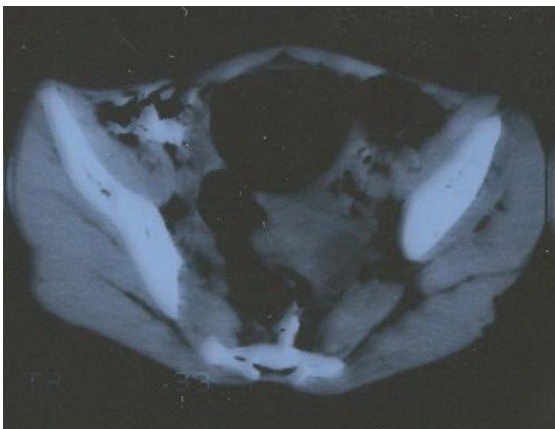
Figure 1. GANT in the mesentery of small bowel. Figure 2. CT scan showed a tumor mass in the mesentery of the